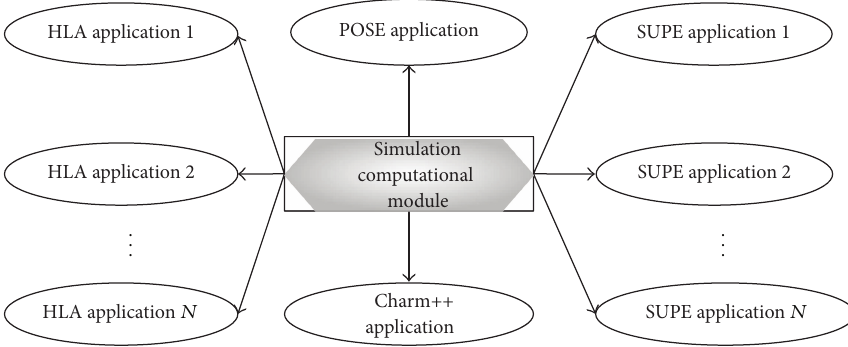
Figure 6: Model reuse across different